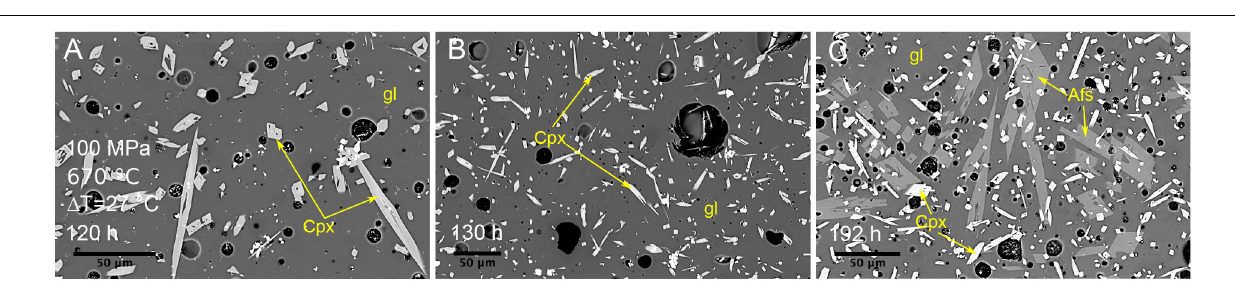
FIGURE 3 | Backscattered SEM images of textures obtained from isobaric cooling experiments at 100 MPa, 670 ◦ C and (cid:49) T = 27 ◦ C. (A) Sample C135: experimental duration of 120 h. (B) Sample C154: experimental duration of 130 h. (C) Sample C136: experimental duration of 192 h. Afs, alkali feldspar; Cpx, clinopyroxene; gl,